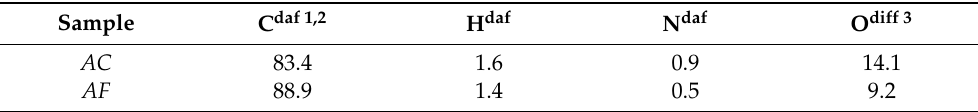
Table 4. Elementary analysis of the activated carbons [% wt.].